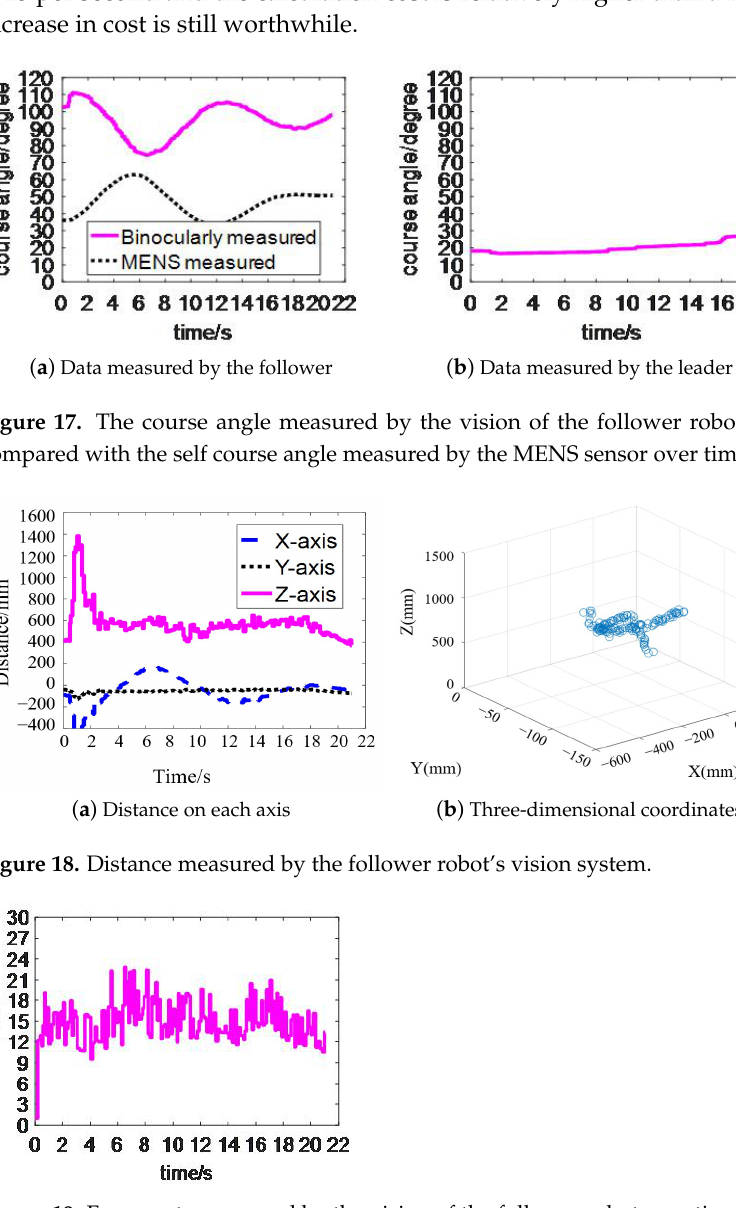
Figure 19. Frame rate measured by the vision of the follower robot over